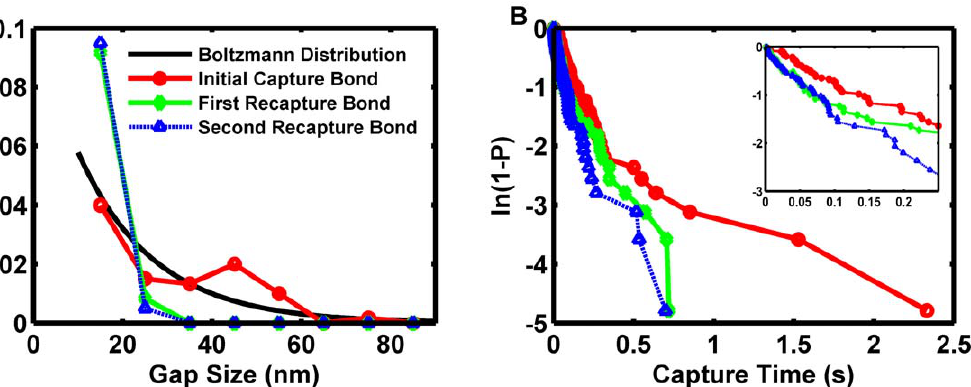
Figure 10. Molecular capture spans the gap and enhances recapture events. The simulation results from Figure 9 were pooled to obtain 60 events for each capture bond. (A) An analysis was conducted to investigate the separation of the sphere from the surface when bonds form in the absence of pre-existing bonds. First capture bonds formed efficiently across the range of gap sizes. Solid black line: equilibrium distribution for the gap size. Red circles: distribution of separation distances when the first bond formation event occurs. Green diamonds: distribution of separation distances observed when the first recapture, e.g. second capture, bond forms. Blue dashed line with triangles: distribution of separation distances when the second recapture, e.g. third capture, bond forms. (B) Once the sphere captured to the surface once, the first and second recapture bonds formed more quickly. The characteristic binding times describing the first linear segment (inset) for the initial capture bond, the first recapture bond, and the second recapture bond were 0.143 s, 0.081 s, and 0.085 s, respectively.